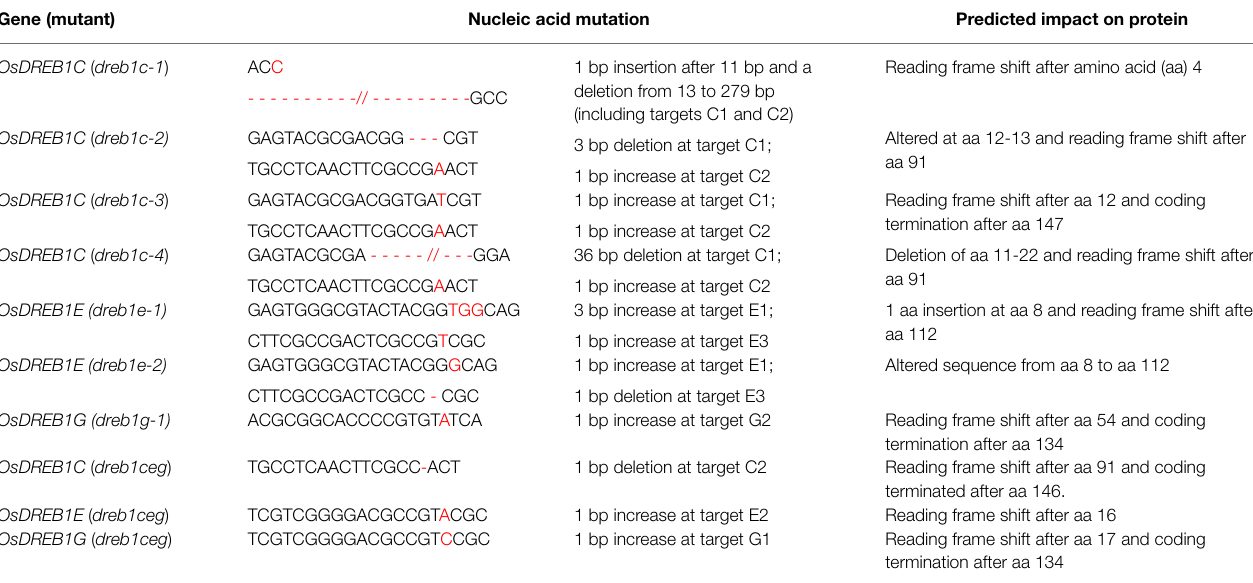
TABLE 1 | Mutations in rice DREB1c , DREB1e , and DREB1g genes generated via the CRISPR/Cas9 system. Gene